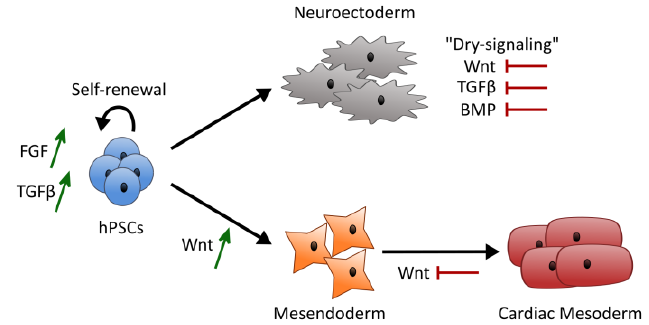
Figure 7. Model summarizing the overall results obtained using a dry-signaling multiparameter approach. Wnt signaling activation showed to be dominant over FGF and TGF β signaling driving hPSCs towards mesendoderm lineages. A synergy of FGF and CHIR was observed providing higher ectoderm scores or higher mesoderm scores and contributing to lower pluripotency scores. Contribution of FGF and TGF β signaling to maintain pluripotency scores seems to be connected with the negative contribution of both FGF and TGF β signaling to ectoderm scores, with absence of inputs inducing cells to follow their inner circuitry towards neuroectoderm.